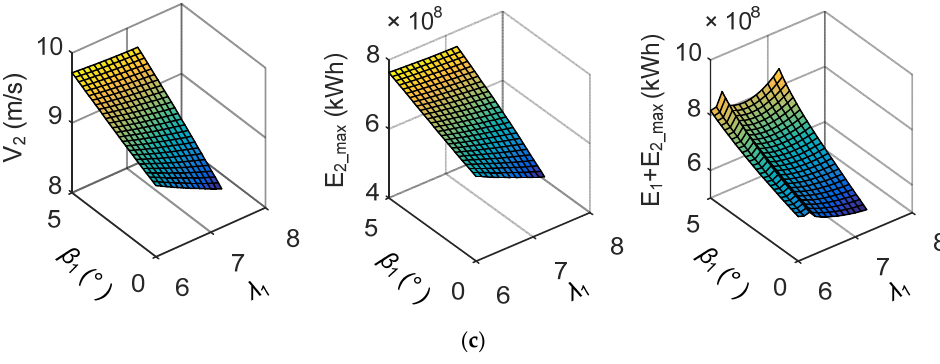
Figure 17. Wind speed of WT 2 , maximum energy production of WT 2 , and total active power generation of WT 1 and WT 2 in terms of the pitch angle and tip speed ratio of WT 1 at wind direction of 270° and at the ambient wind speed of: ( a ) 7 m/s; ( b ) 9 m/s; ( c ) 11 m/s.